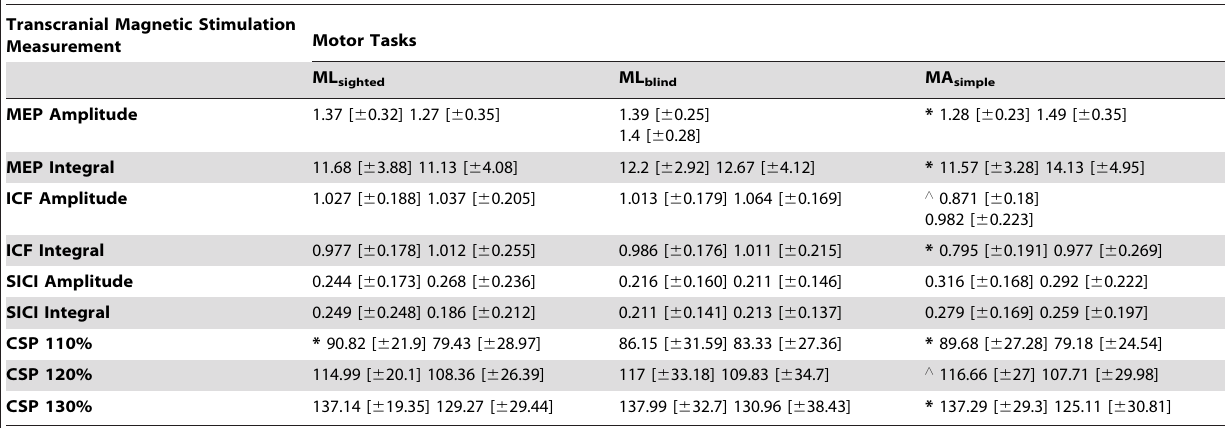
Table 1. Results of transcranial magnetic stimulation (TMS) measures.